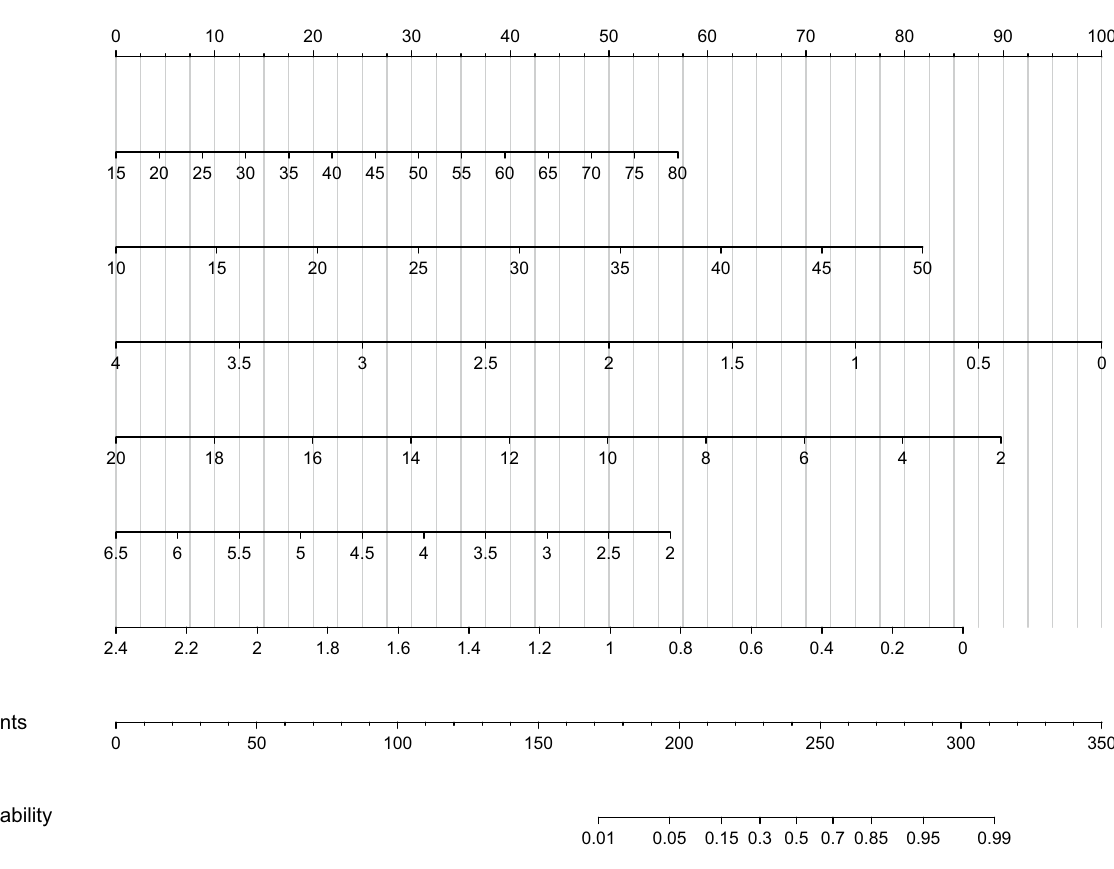
Figure 4. Nomogram based on the laboratory model; ALB albumin, HDL high density lipoprotein, C3 complement 3, RBC red blood cell, MN membranous